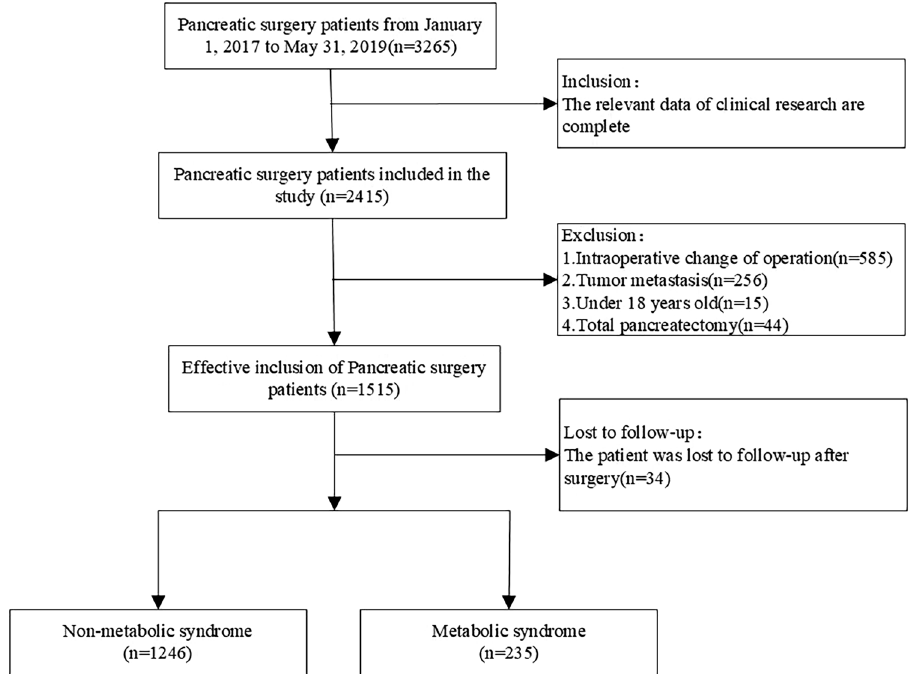
Figure 1. Flowchart for the process of